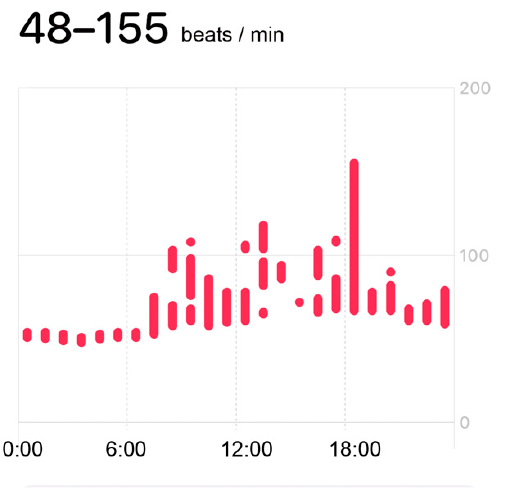
Figure 1. Pulse rate chart recorded using the iPhone.